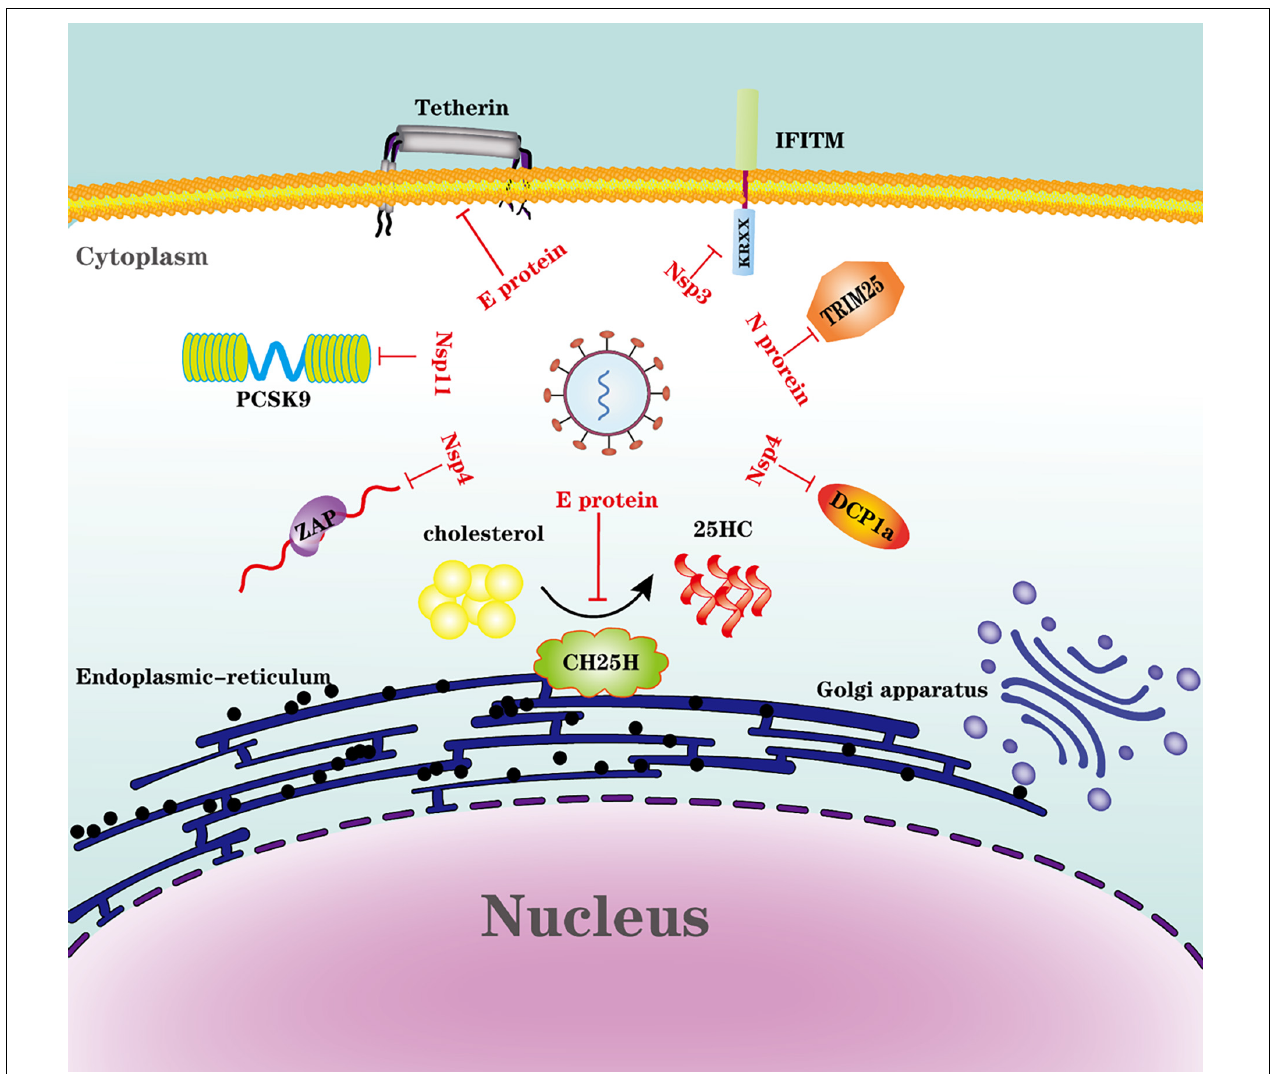
FIGURE 3 | Evasion of ISGs and intrinsic antiviral proteins by PRRSV. Viral proteins from PRRSV engage multiple strategies to evade the restriction of ISGs or intrinsic antiviral